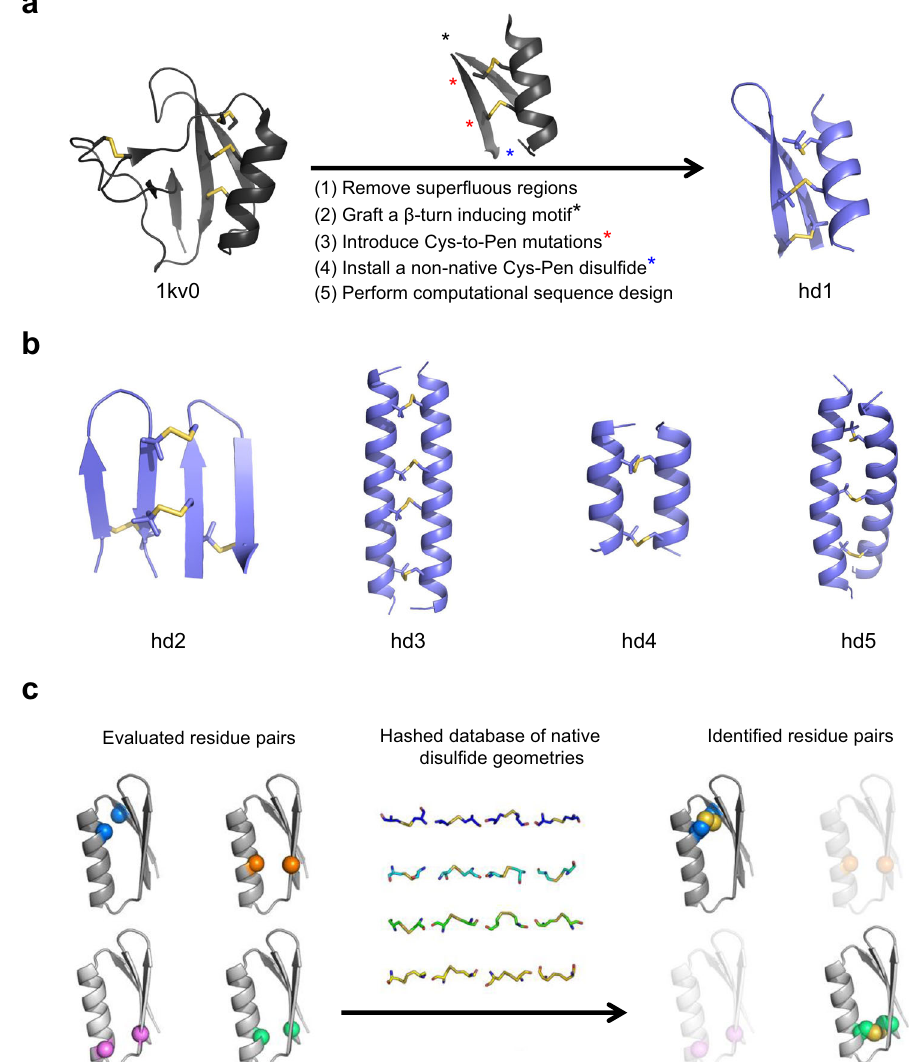
Fig. 2 Design principle for structurally ordered peptide heterodimers. a Typical work fl ow of designing peptide heterodimers from disul fi de-rich mini- proteins (e.g., from 1kv0 to hd1). b Designed heterodimers (hd2 ‒ hd5) crosslinked through 2 ‒ 4 interchain disul fi de bonds. Sequences of these peptides were given in Supplementary Table 1. c Schematic representation of the RPX method for the identi fi cation and placement of disul fi des within protein/ peptide scaffolds. PDB output fi les for these designed peptides are provided in a Supplementary fi